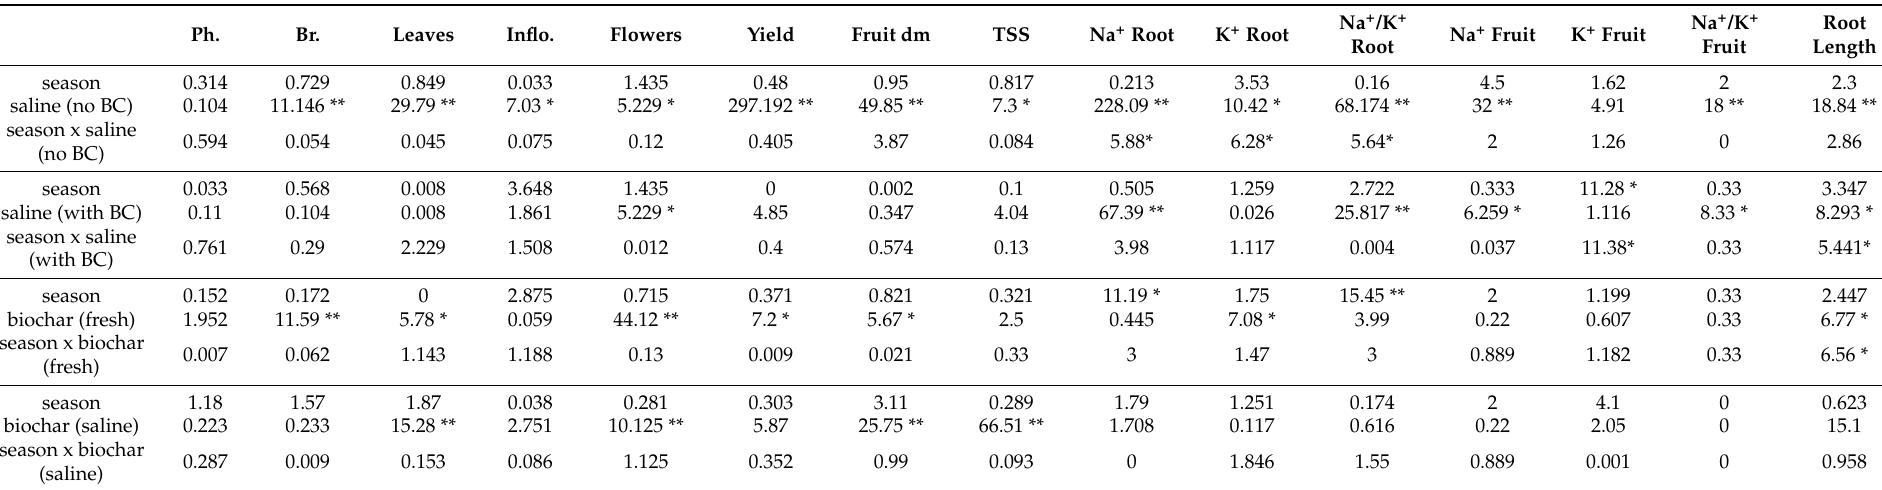
Table 2. Analysis of variance indicating the effect of season, biochar addition, saline irrigation regime, and the corresponding interactions on tomato crop plants’ traits and